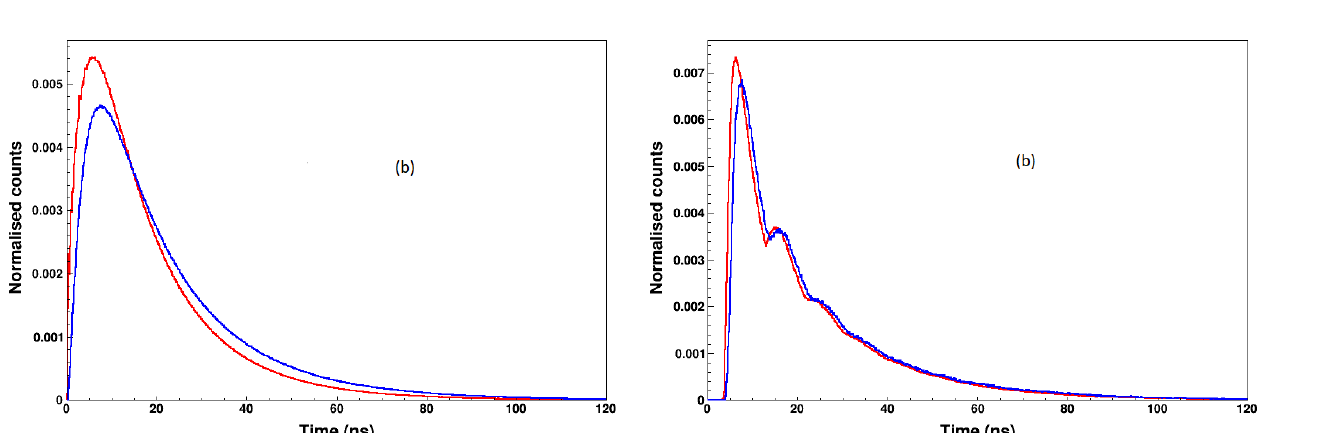
Fig 2. Simulated slab geometry (a) and average output pulse shapes (b) for neutron (blue) and gamma (red) radiation. The dimensions of the slab are 5 cm x 15 cm x 100